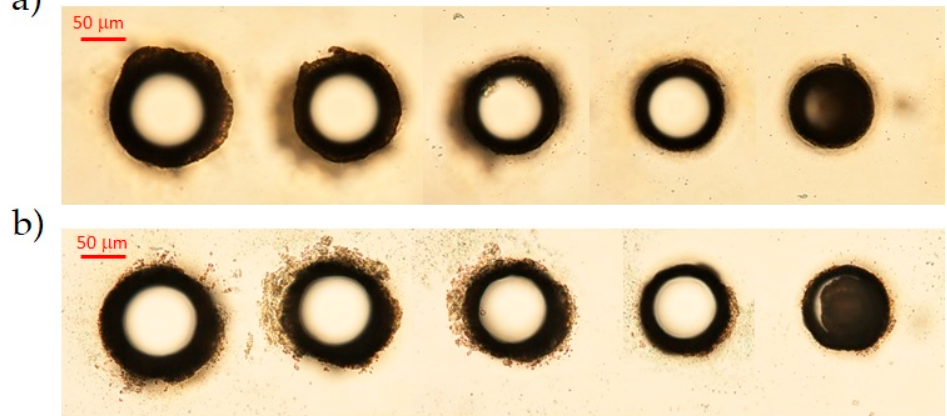
Figure 2. Optical microscope images (top ( a ) and bottom ( b ) surfaces) showing the dependence of the hole diameter on the BB pulse energy in the case of the 200 μ m thick AF32 glass sample. From left to right, the energy per pulse was, respectively, 250 μ J, 197 μ J, 153 μ J, 118 μ J and 95 μ J (with 3% variance). The holes were drilled in one machining pass with 60 writing circles.